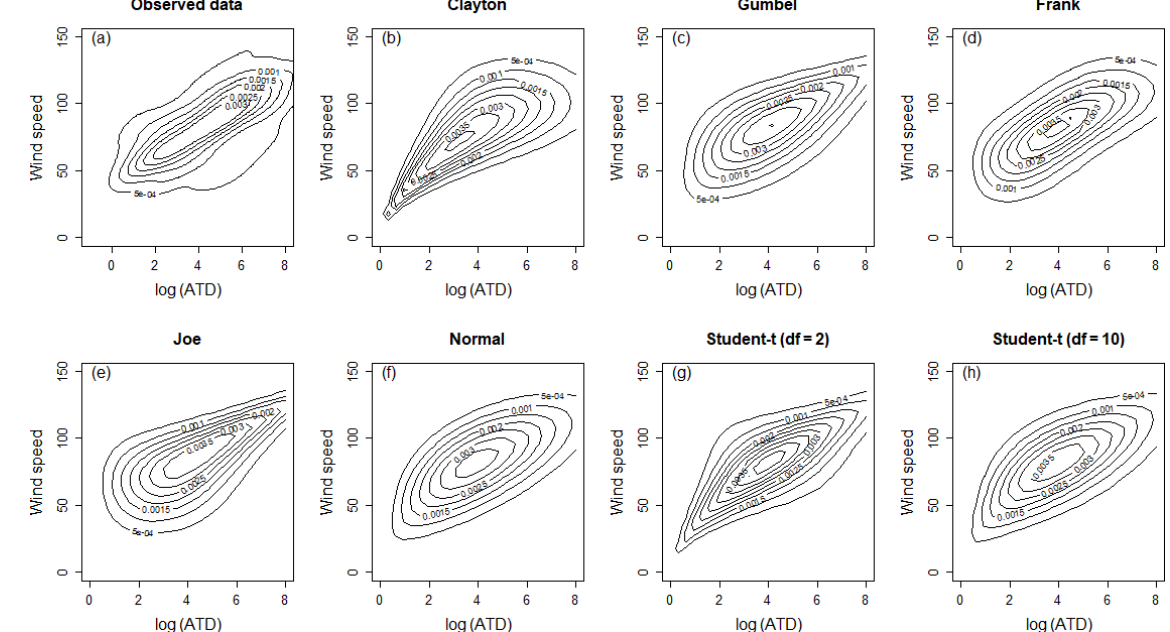
Figure 5. Contour plot of the kernel density estimate of the observed data is shown in (a) . The contour plot of the fitted bivariate copulae for the (b) Clayton, (c) Gumbel, (d) Frank, (e) Joe, (f) normal, (g) Student t with 2 degrees of freedom, and (h) Student t with 10 degrees of freedom distributions. Landfalling wind speed measured in knots is given on the y axis, and log-transformed area of total destruction (ATD) is given on the x